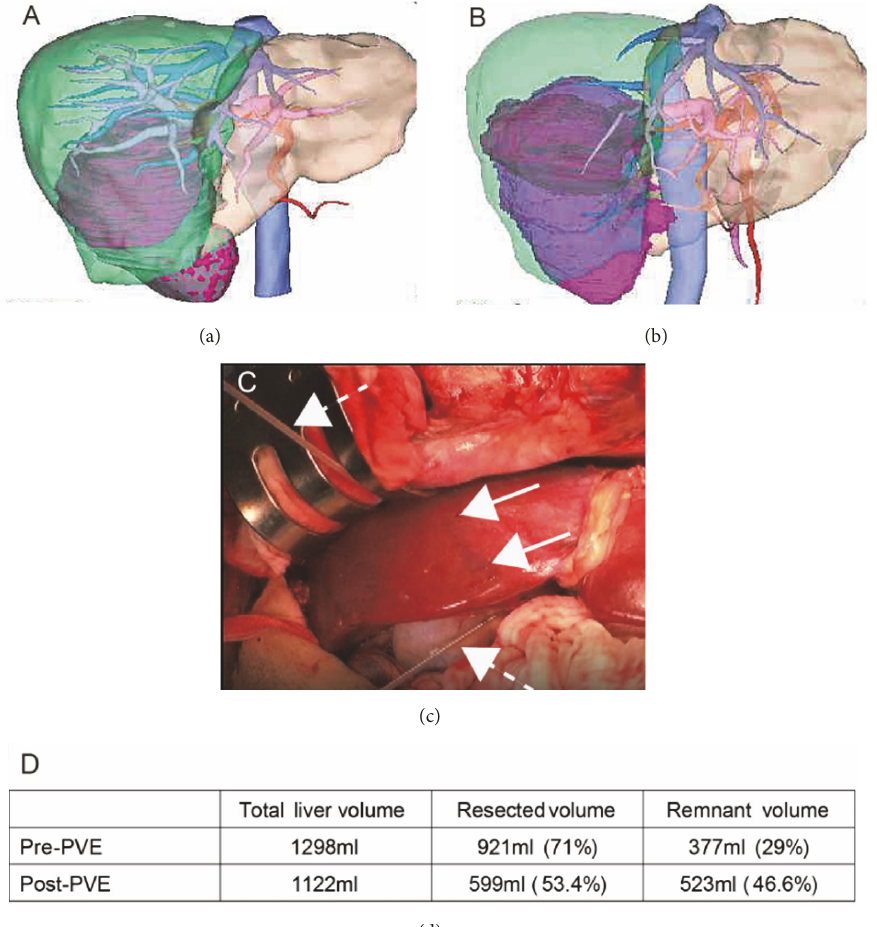
Figure 3: Result of volumetric analysis by the Synapse Vincent Work Station ((a) before portal vein embolization (PVE), (b) after PVE, D: estimated liver volume) and intraoperative finding of the liver (c) . In 3-dimensional graphics of (a) and (b), estimated resected liver is shown in green, estimated remnant liver is light brown, IVC and major veins are blue, portal vein is pink, and kidney is purple. The estimated resected tumor liver volume was 921ml (71% of whole liver) at pre-PVE status (a). After PVE, estimated resected liver volume reduced to 599 ml (53.4% of whole liver) (b). Intraoperative findings showed morphologically shrunken right liver parenchyma (arrows show the midline) due to portal ischemia (c). Hanging tube is shown by dotted arrows. Total and estimated liver volume are shown